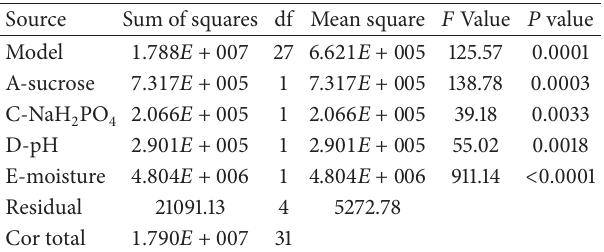
Table 2: ANOVA for selected factorial model.